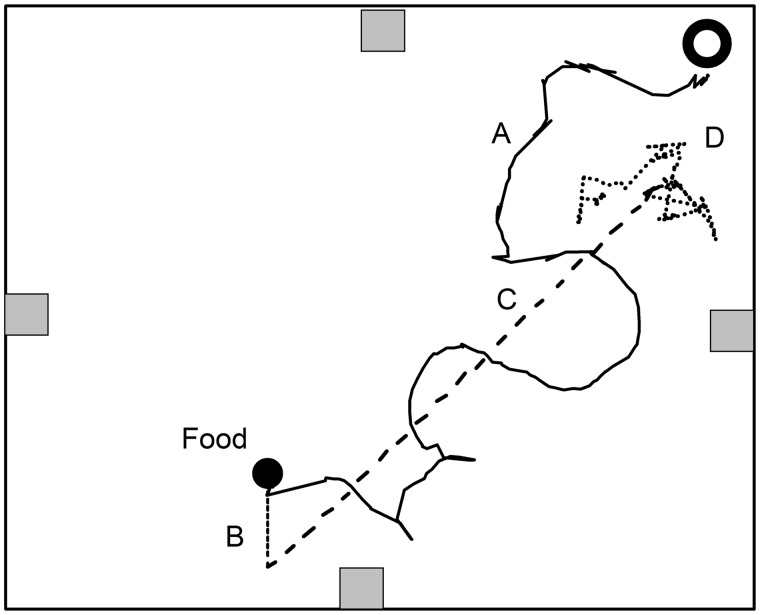
Top-down view of an arena (80 cm × 80 cm × 35.5 cm) with an example crayfish path digitized at 1 point per second. The gray squares along the sides represent aerators. The open black circle is the PVC burrow and the closed black circle is the location of the food resource. The crayfish path consists of the outbound search (A), the treadmill translation (B), the linear return path (C), and finally, a localized search pattern when the burrow is not found (D). This is a single example of a real homing pathway for a crayfish.